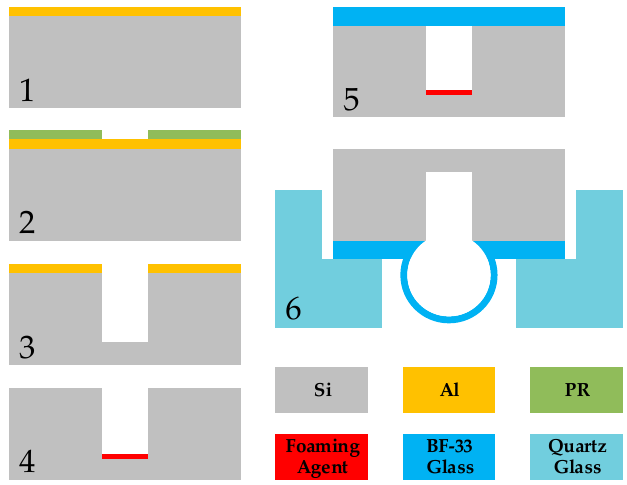
Figure 4. Fabrication process flow of a glass-blown spherical shell resonator.